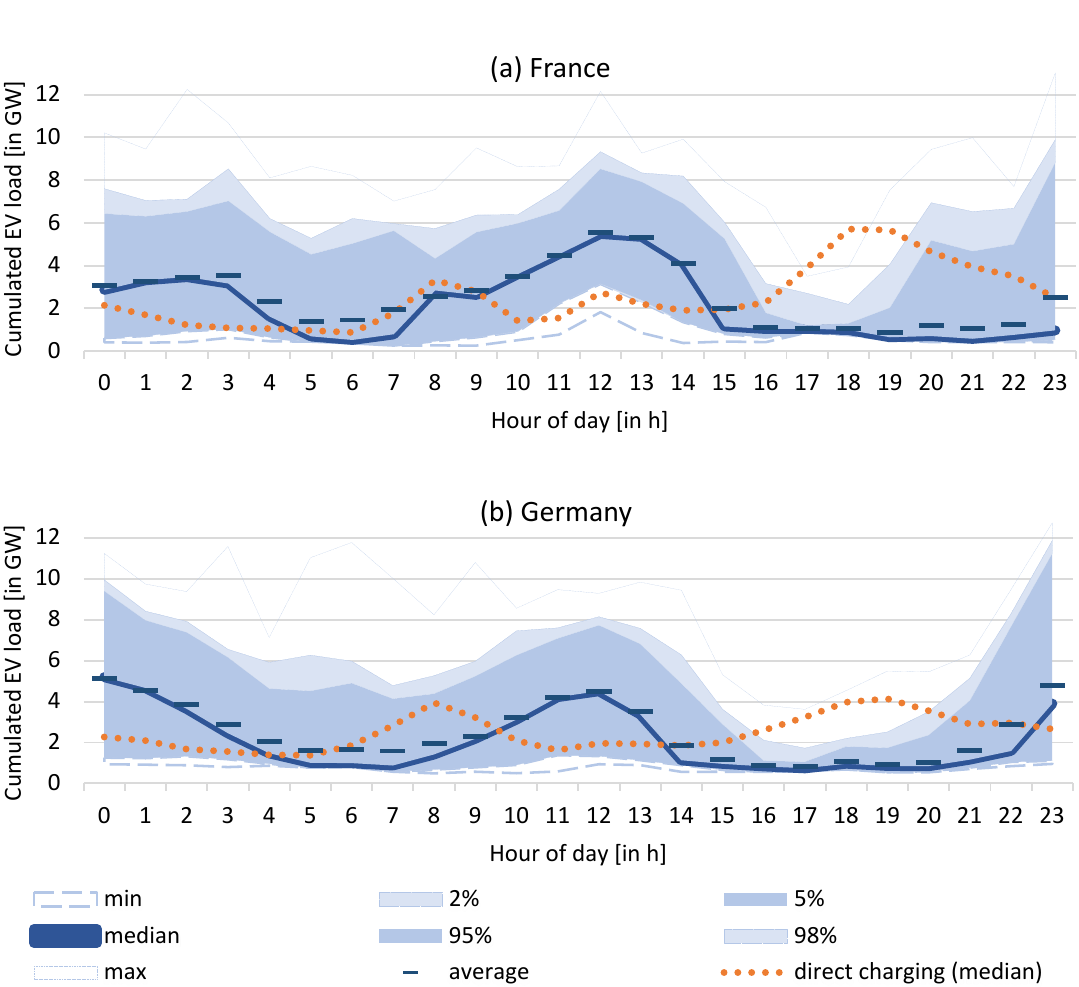
Figure 3. Cumulated daily PEV load of direct and controlled PEV charging in ( a ) France and ( b ) Germany in 2030.